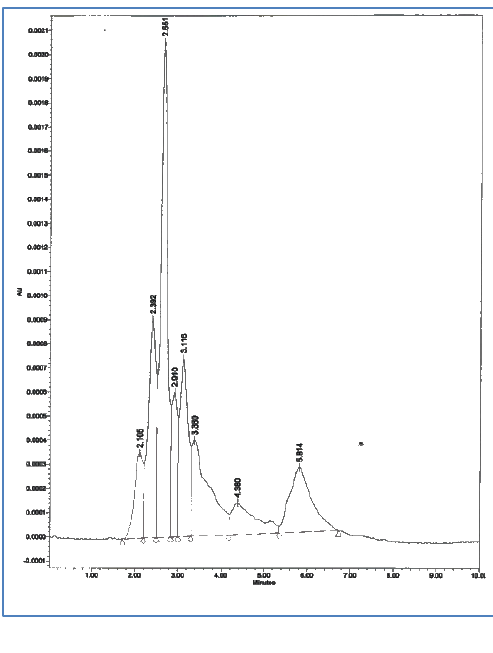
Figure (4):- HPLC of hydrolyzed n-butanol fraction